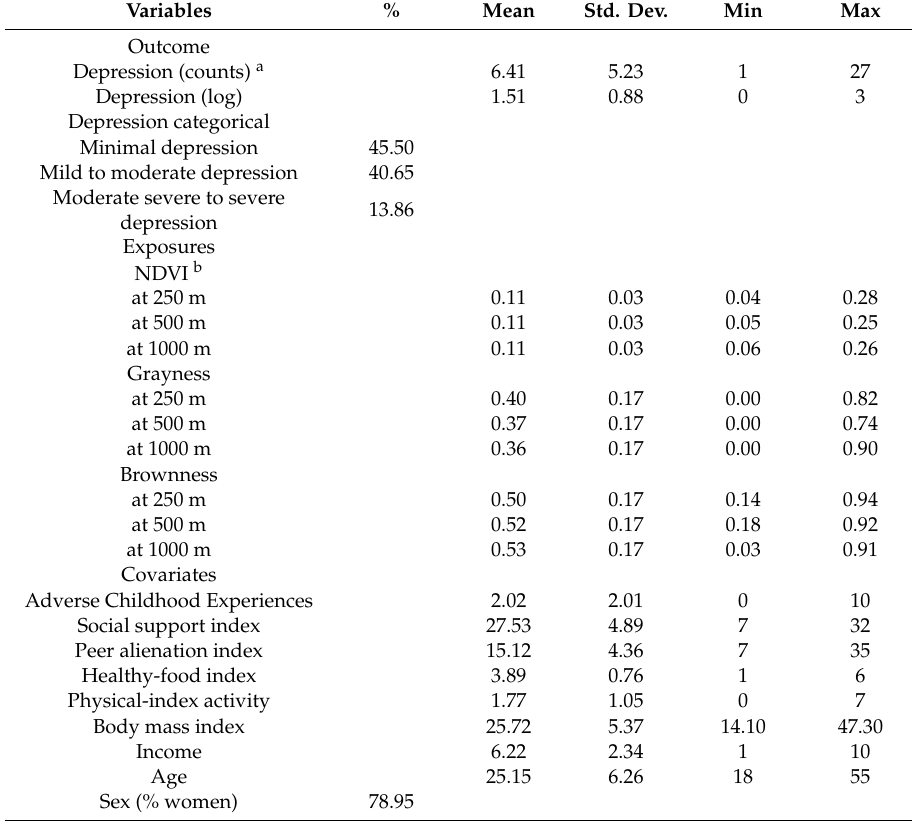
Table 1. Description of Sample ( n =